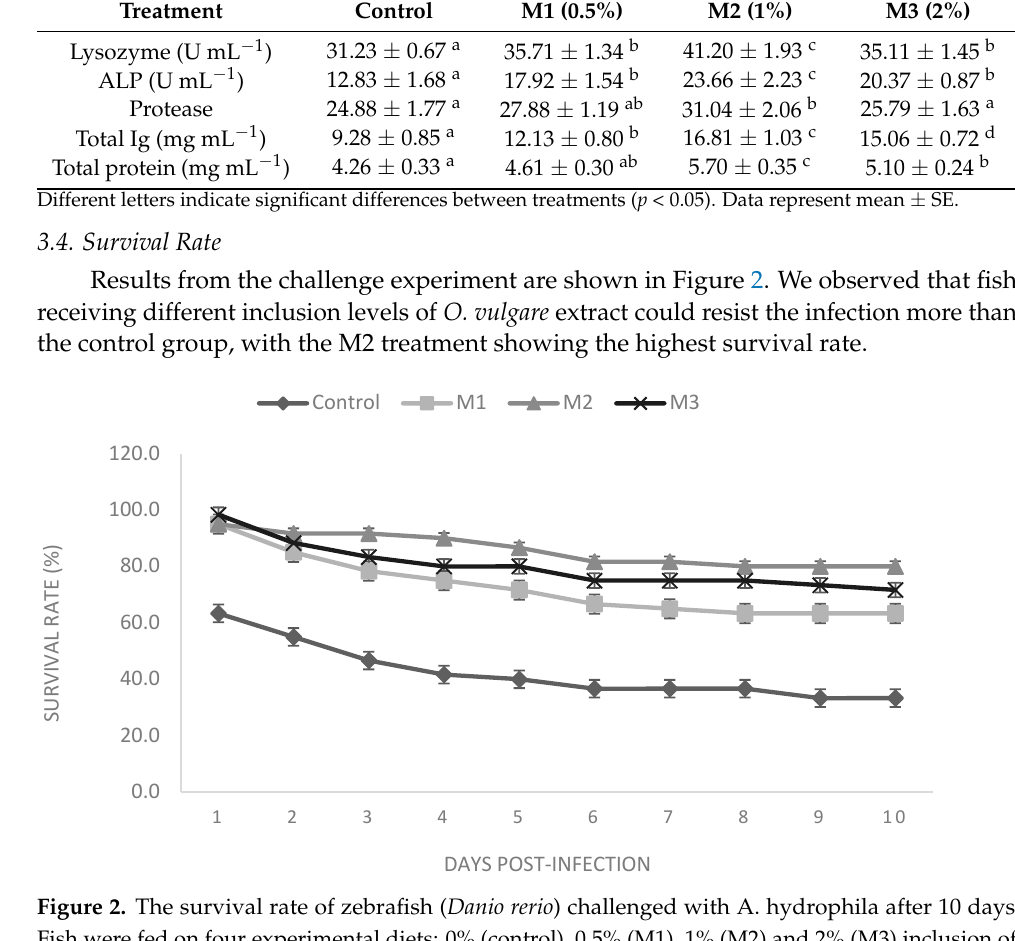
Table 3. Mucosal immune parameters: lysozyme, ALP, total Ig, protease activity and total protein in zebrafish fed on four experimental diet regimes: 0% (control), 0.5% (M1), 1% (M2) and 2% (M3) inclusion of the extract per kg diet for eight weeks.